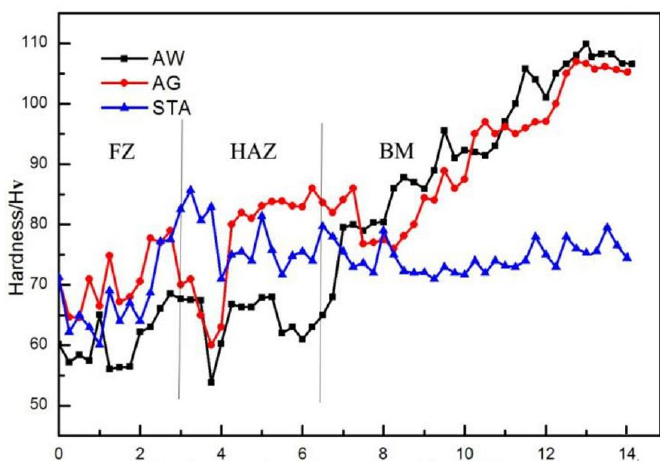
Figure 5. Hardness distributions of different treated joints.